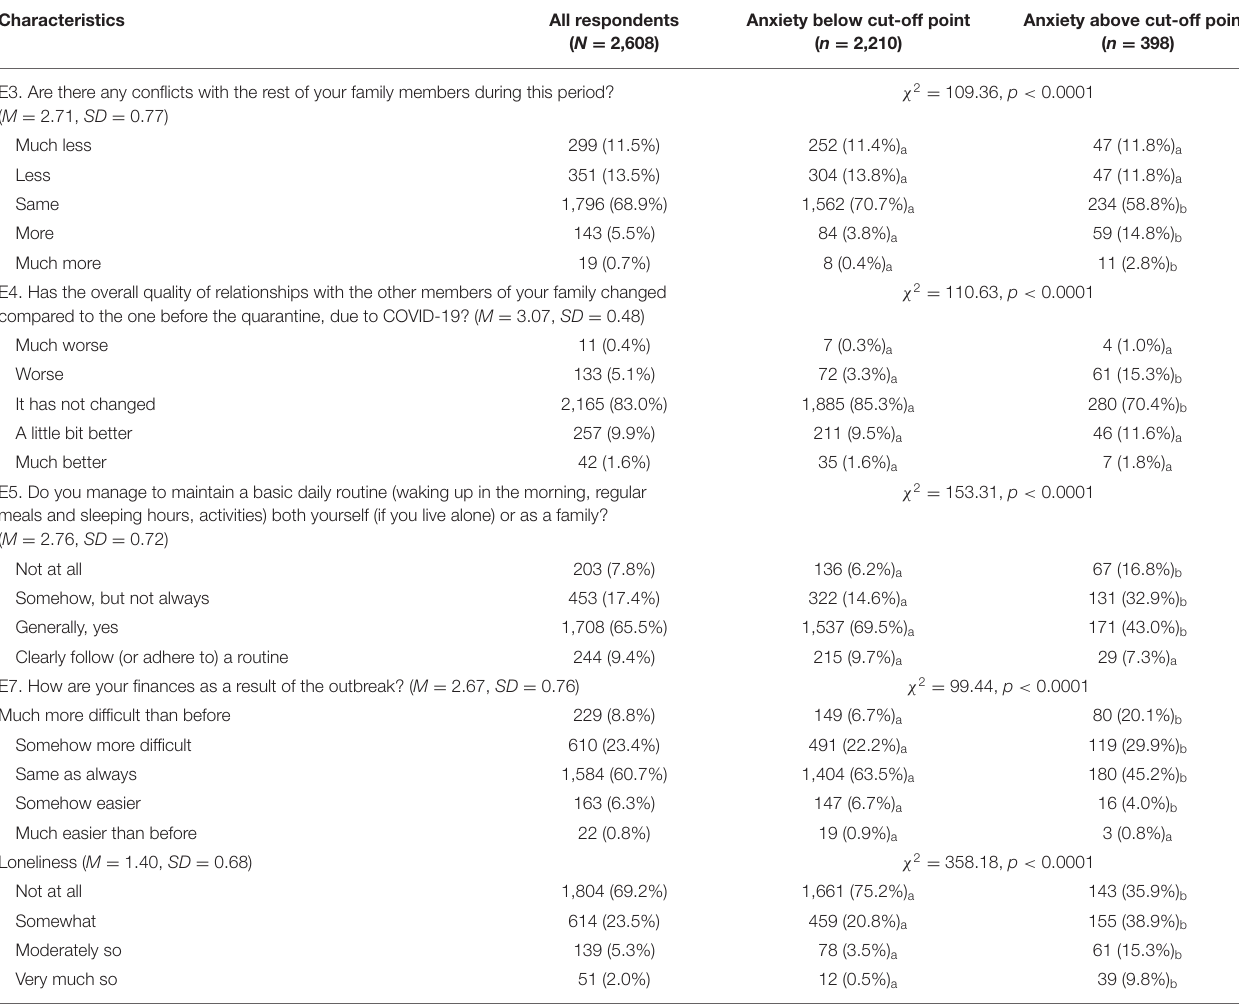
TABLE 6 | The association of anxiety and quality of relationships, daily routine and financial difficulties during COVID-19 epidemic ( n = 2,608). Characteristics All respondents